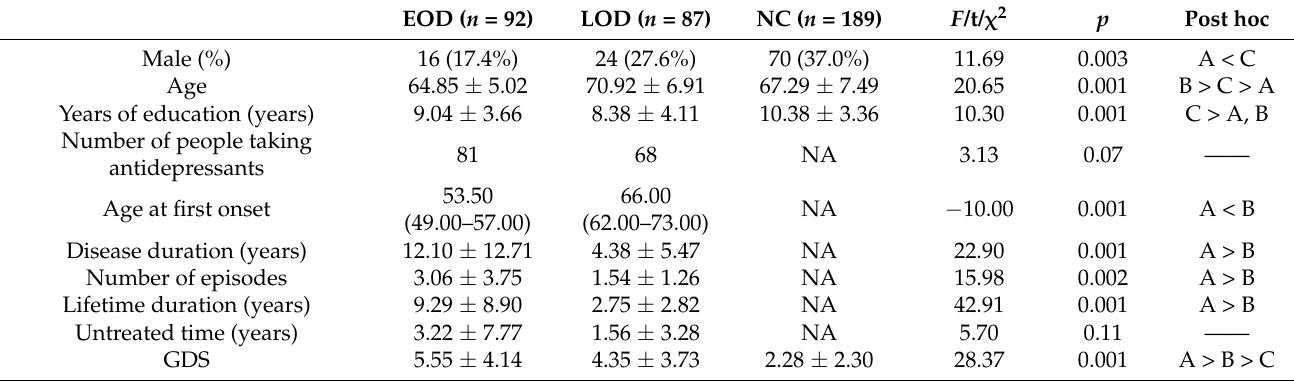
Table 1. Demographic and clinical data of EOD, LOD and NC